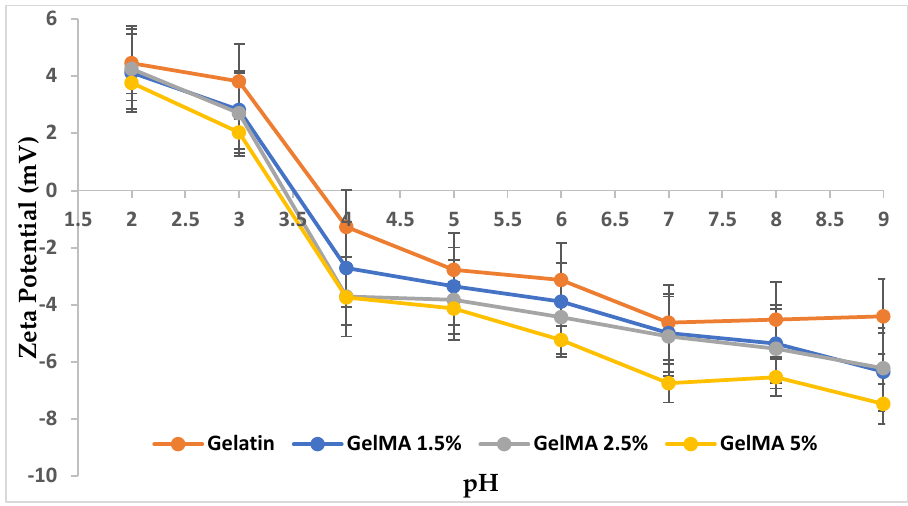
Figure 4. The isoelectric point (IP) of all analyzed